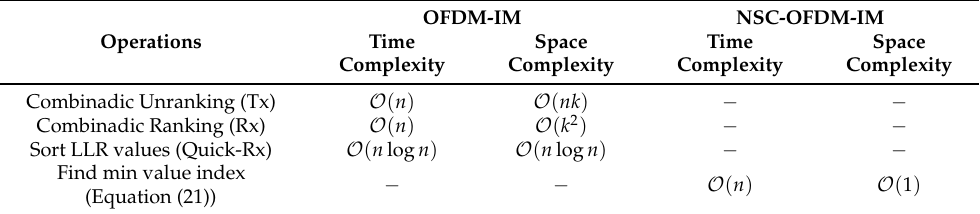
Table 5. Complexity comparisons between NSC-OFDM-IM and OFDM-IM schemes.